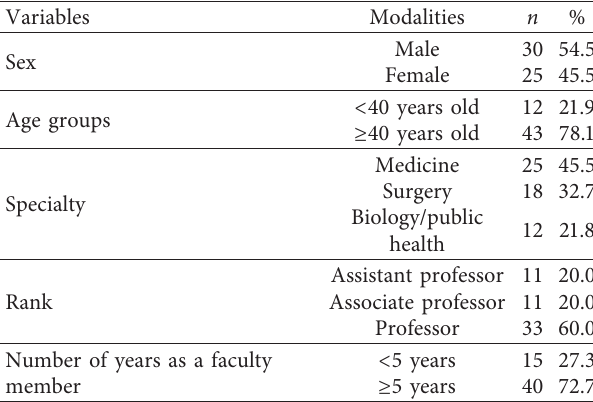
Table 1: Description of the study participants’ characteristics ( n � 55).